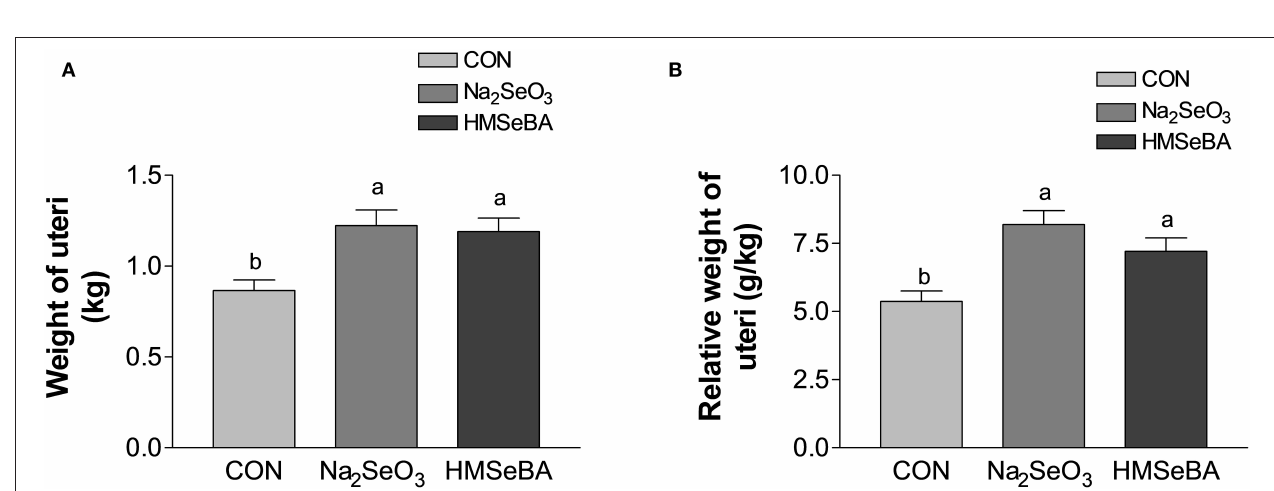
FIGURE 2 | Effects of dietary selenium supplementation on the weight of uteri (A) and relative weight of uteri (B) of gilts. Data are expressed as means values and standard error, n = 5. Mean values with different superscript letters were significantly different ( P < 0.05). CON, basal diet; Na 2 SeO 3 , 0.3mg Se/kg Na 2 SeO 3 ; HMSeBA, 0.3mg Se/kg